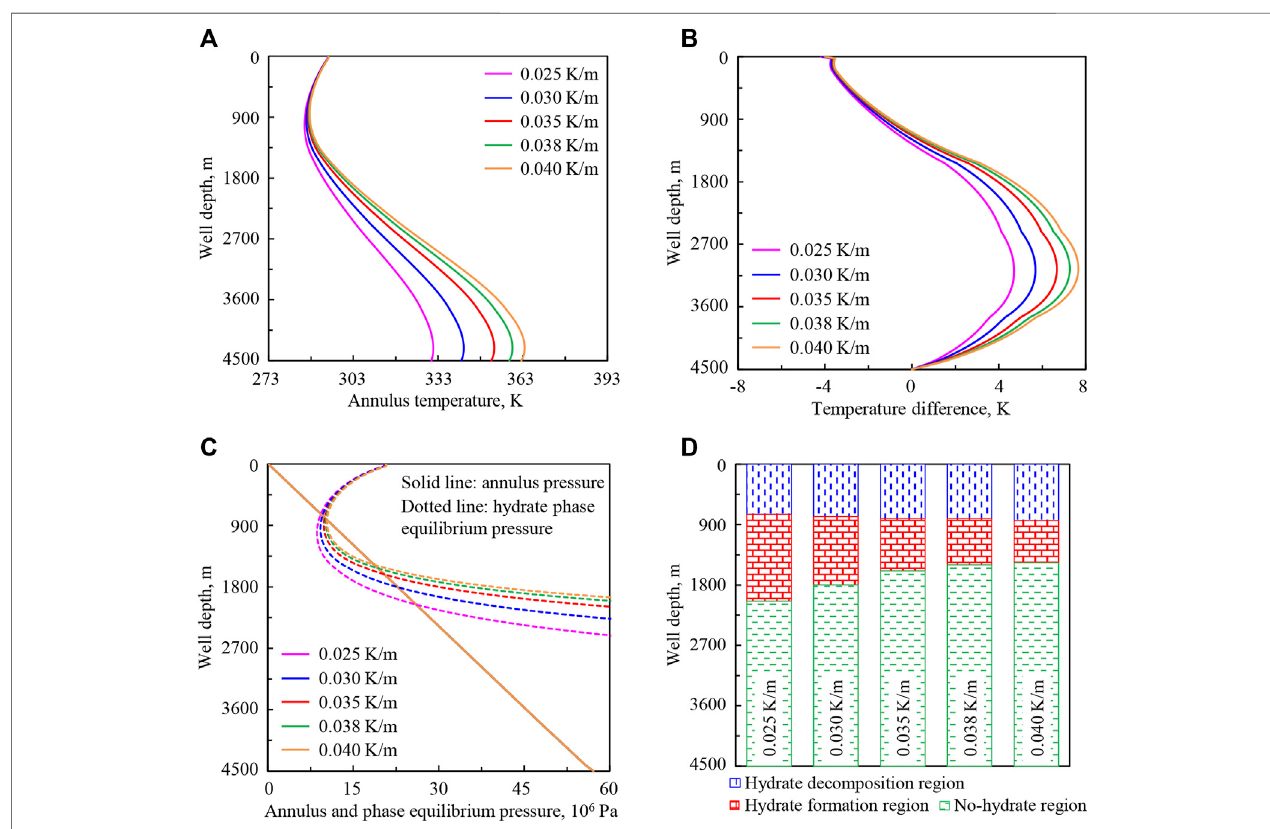
FIGURE 12 | Variation regularities of wellbore temperature fi eld, pressure fi eld, and hydrate formation region in deep-water drilling under different geothermal gradients: (A) annulus temperature, (B) temperature difference between the drilling fl uid in the annulus and in the drill string, (C) annulus pressure and phase equilibrium pressure, (D) hydrate formation region. The solid lines under different geothermal gradients in (C) are overlapped.